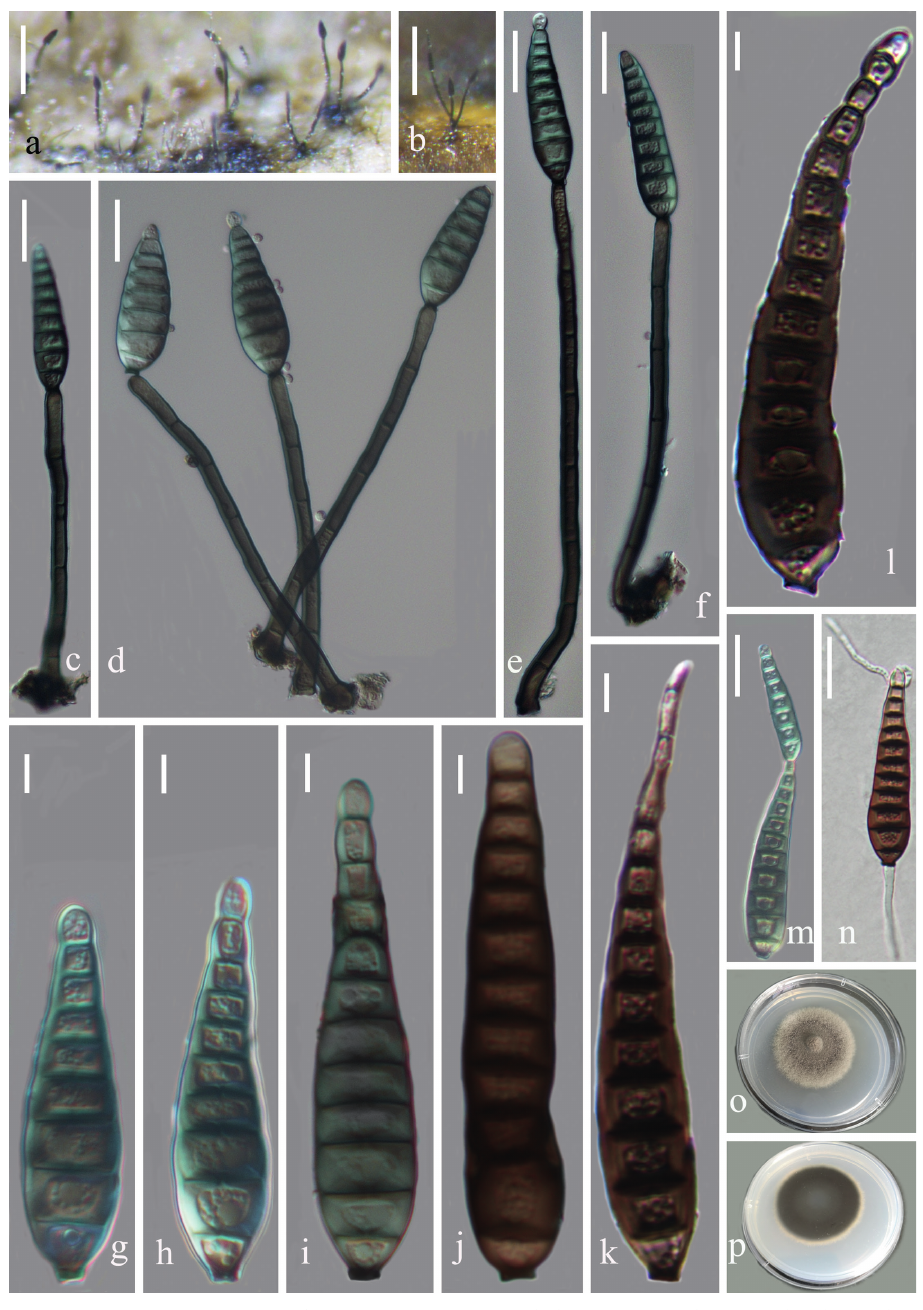
Figure 4. Distoseptispora yunjushanensis (HFJAU 10005, holotype) a, b colonies on bamboo culms c–f conidiophores with conidia g-i young conidia j-l mature conidia m conidium with proliferation n germinating conidium o, p culture on PDA from above and reverse. Scale bars: 100 μm ( a, b ), 20 μm ( c–f, m, n ), 5 μm ( g–l